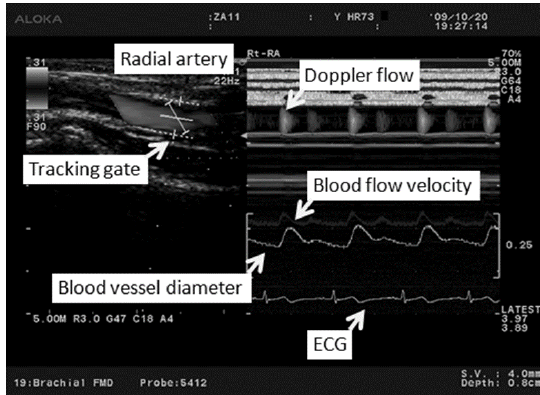
Figure 2. The image on the left shows the radial artery and the position of the tracking gate on the artery. The image on the right shows the changes in the vessel diameter, Doppler flow and flow velocity determined using an automated edge detection device and computer analysis software.